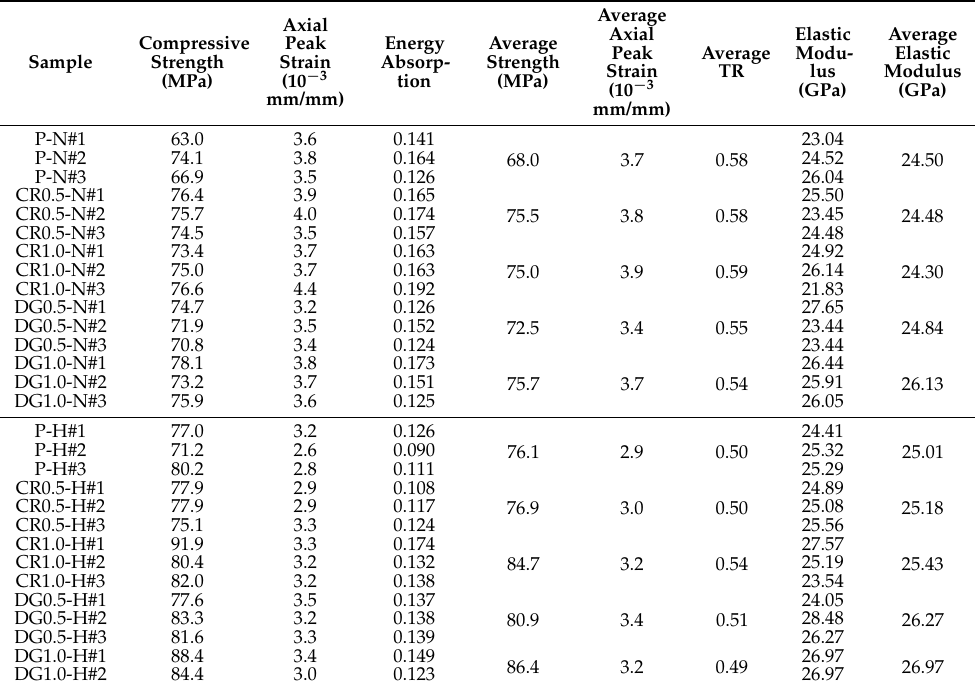
Table 4. Monotonic compressive properties of the